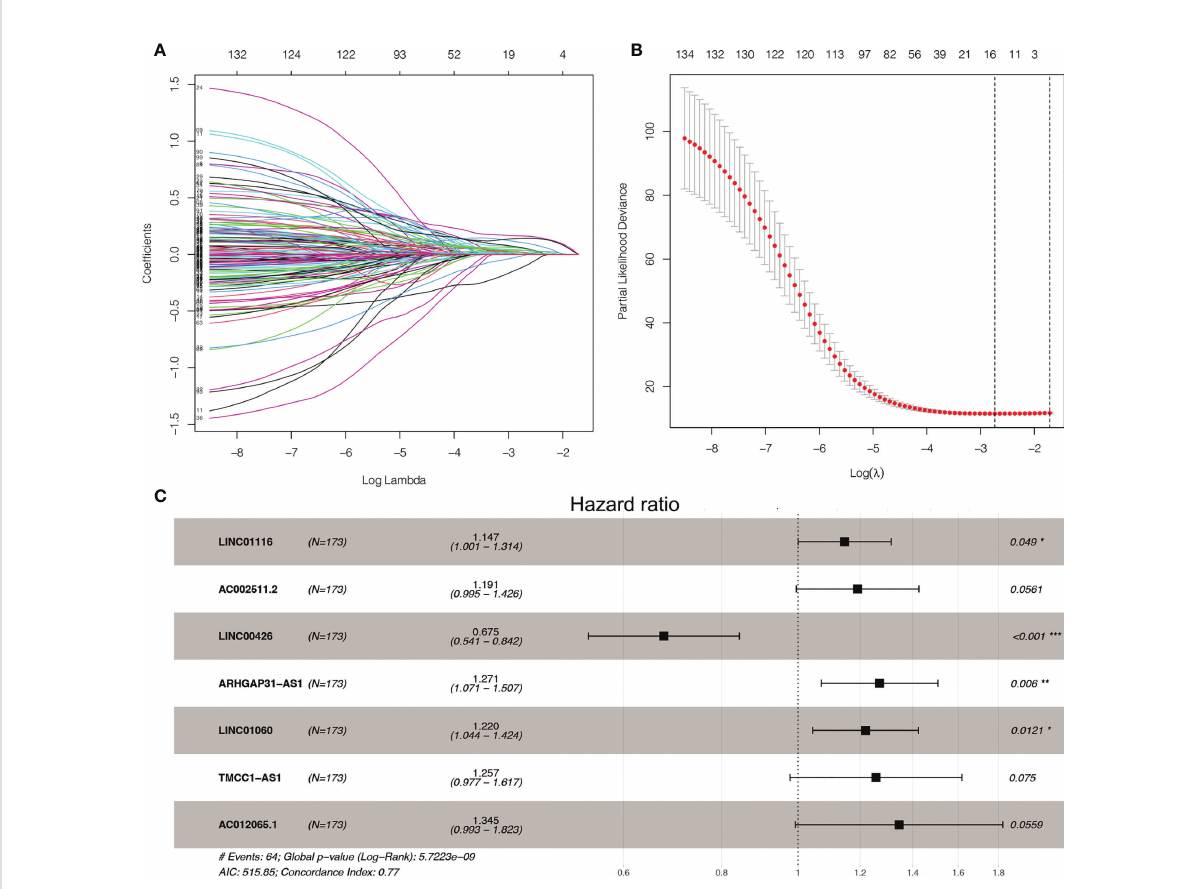
FIGURE 3 LASSO and Cox regression for tuning parameter selection. (A) LASSO coef fi cient pro fi les of the 136 AME-related lncRNAs. (B) Plots of the ten- fold cross-validation error rates. (C) Forest map of the seven prognostic lncRNAs by multivariate Cox